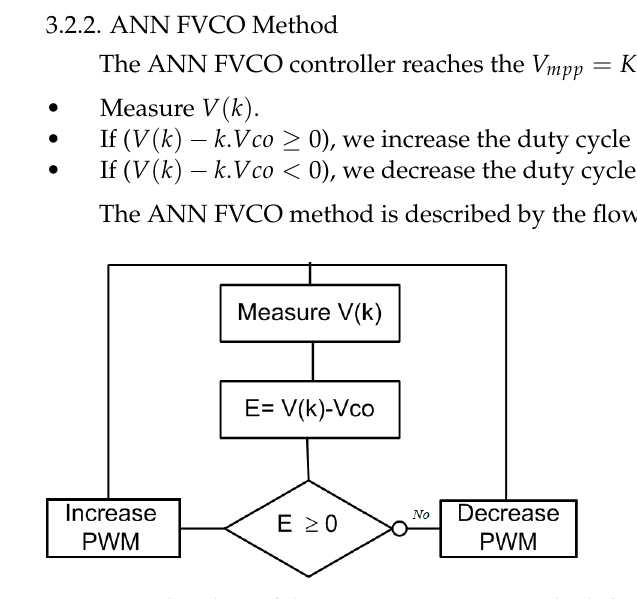
Figure 11. Flowchart of the ANN FVCO MPPT method